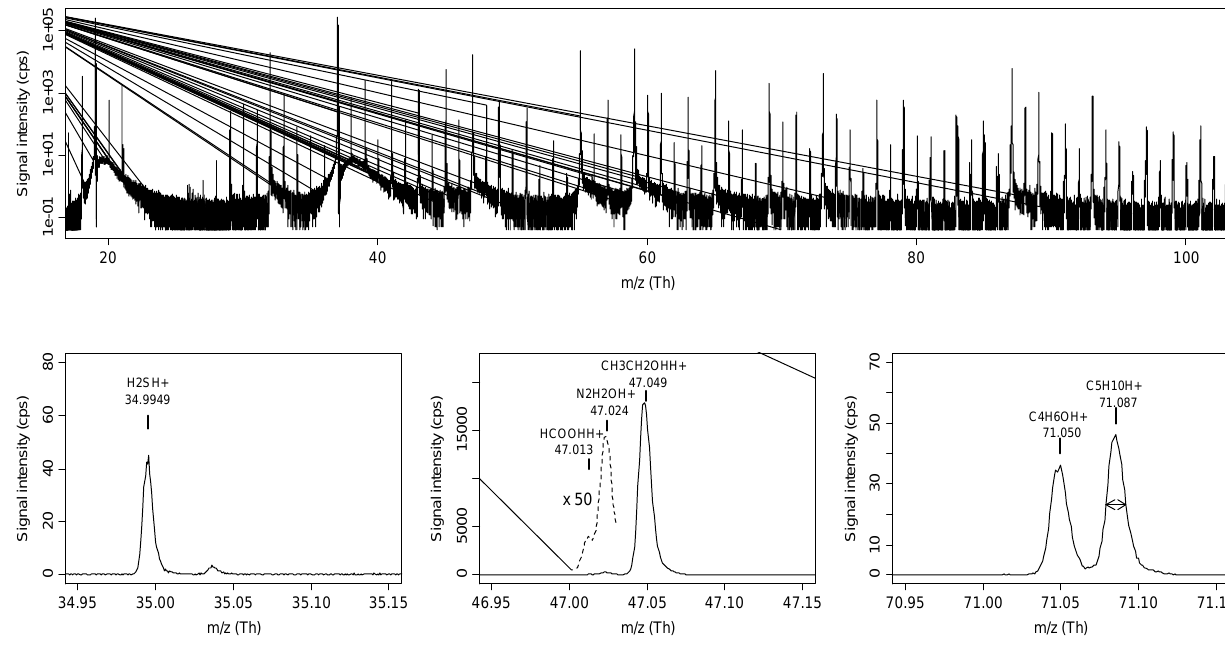
Figure 2. PTR-TOF-MS spectrum of a cheese sample headspace. The upper panel shows the mass region (20–100 Th). The lower panels enlarge the regions around few selected peaks. Reprinted with permission from ref. [60]. Copyright 2010 John Wiley & Sons,